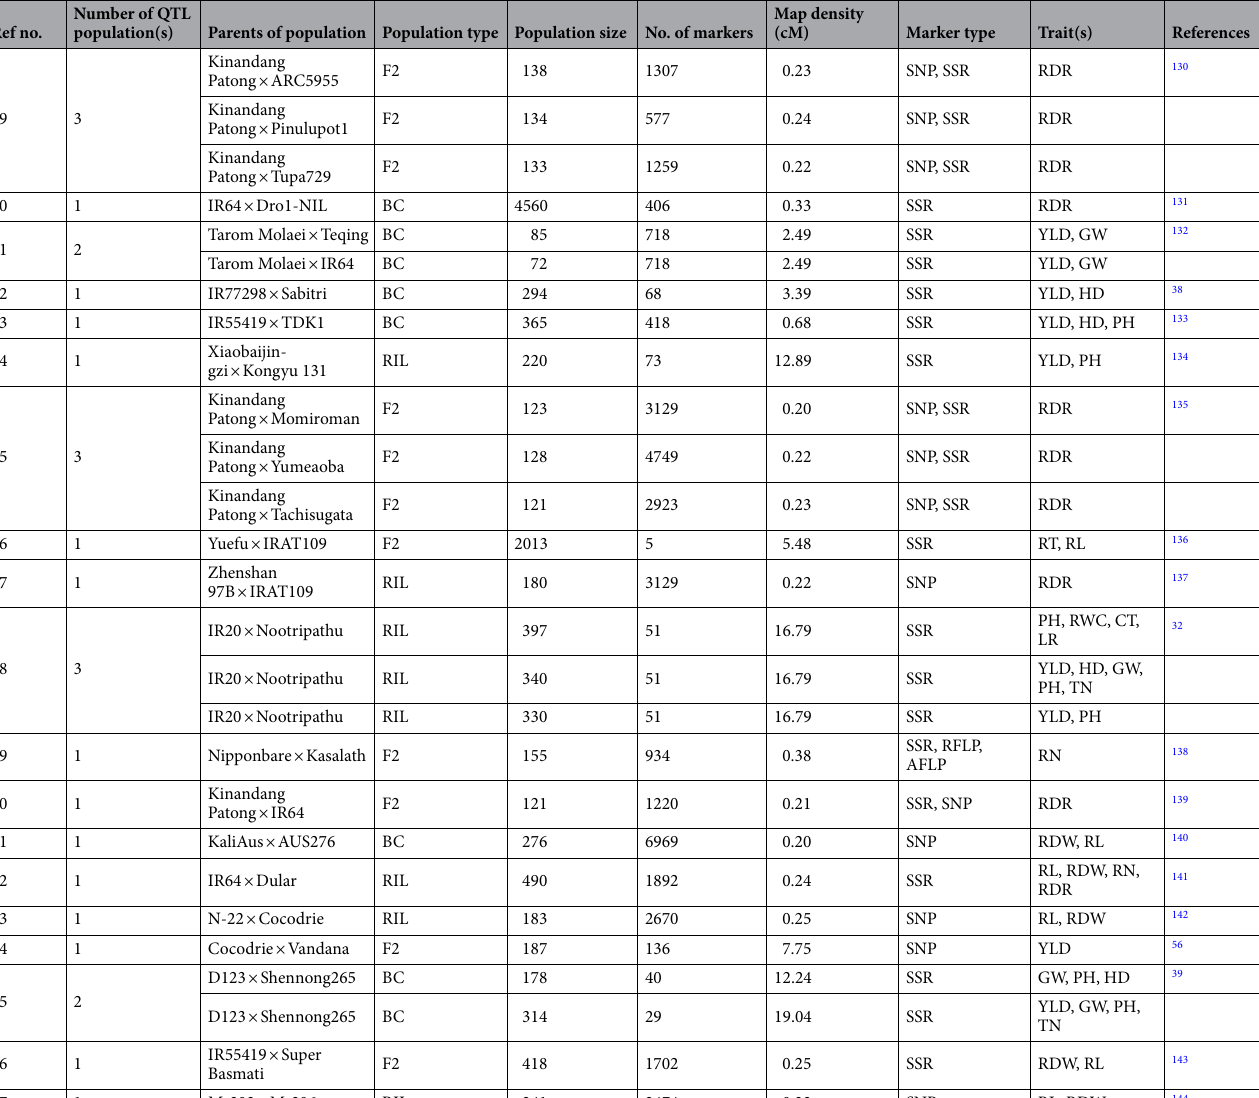
Table 1. Summary of QTL studies used in the QTL meta-analysis for YLD, GW, HD, PH, TN, RWC, CT, LR, LD, DRI, RDW, RL, RN, RT, and DT traits in rice under water deficit condition. BC backcross, DH double haploids, RIL recombinant inbred lines, YLD yield, GW grain weight, PH plant height, HD heading date, TN tiller number, RWC relative water content, CT canopy temperature, LR leaf rolling, LD leaf drying, DRI drought response index, RDW root dry weight, RL root length, RN root number, RT root thickness, RDR ratio of deep